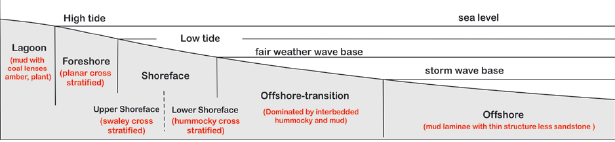
Figure 10: Idealized schematic of the Simplified beach and shoreface environment model. 6.